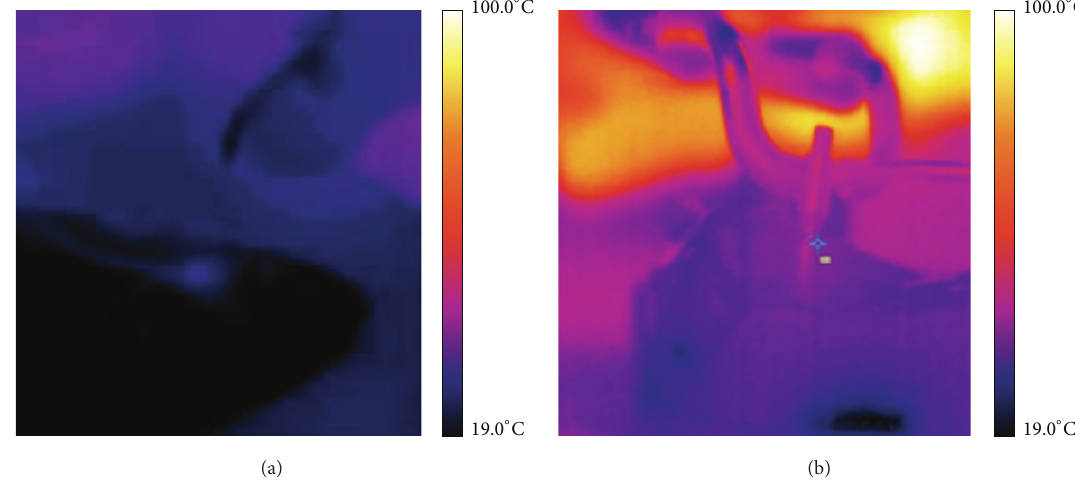
Figure 7: Thermal camera images of laser welding (a) and resistance spot welding (b).